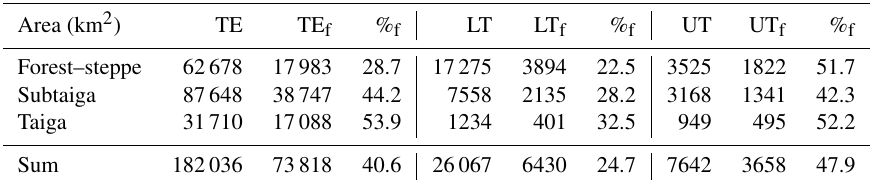
Table 3. Proportion of forest area (f) and total area of different boreal forest types and corresponding treelines. (TE: total ecological unit, LT: lower treeline, UT: upper